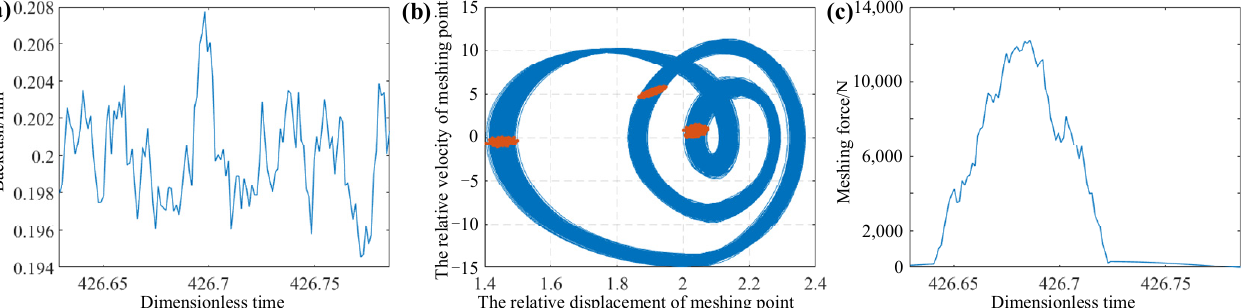
Figure 4. System response and meshing force with D = 1.5. ( a ) Backlash with fractal characteristics. ( b ) Phase diagram and Poincare section diagram. ( c ) Meshing force.